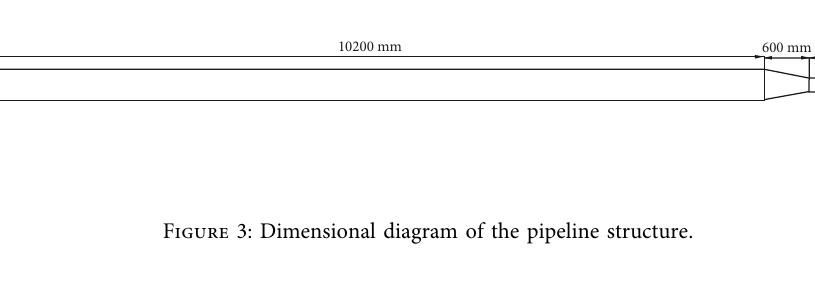
Figure 2: Schematic diagram of pipeline structure form.